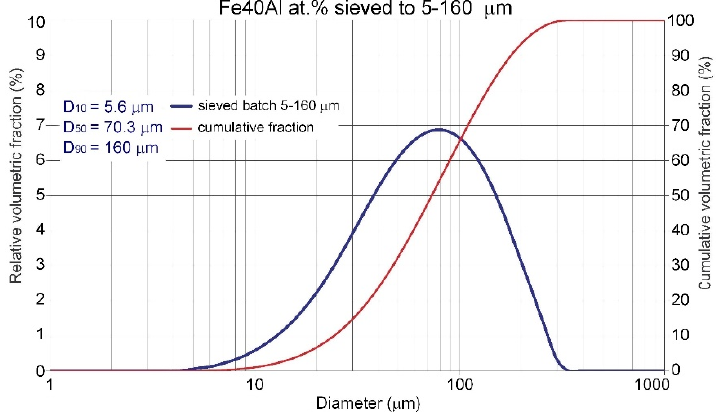
Figure 2. Particle size distribution of the Fe40Al at.% feedstock powder material as declared by the supplier.